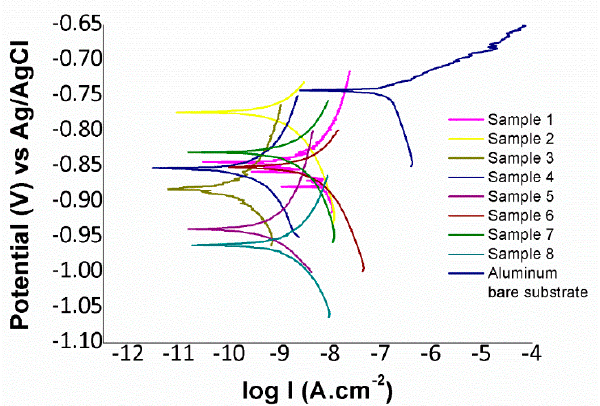
Figure 8. Tafel plots corresponding to the aluminum bare substrate and the different aluminum samples composed of PVC electrospun fiber mats after being tested in 3.5 wt % NaCl aqueous solution. Table 4. Summary table of the Tafel analysis for uncoated aluminum substrate (6061T6) and PVC electrospun coatings of all the samples of this study after being tested in 3.5 wt % NaCl aqueous solution.